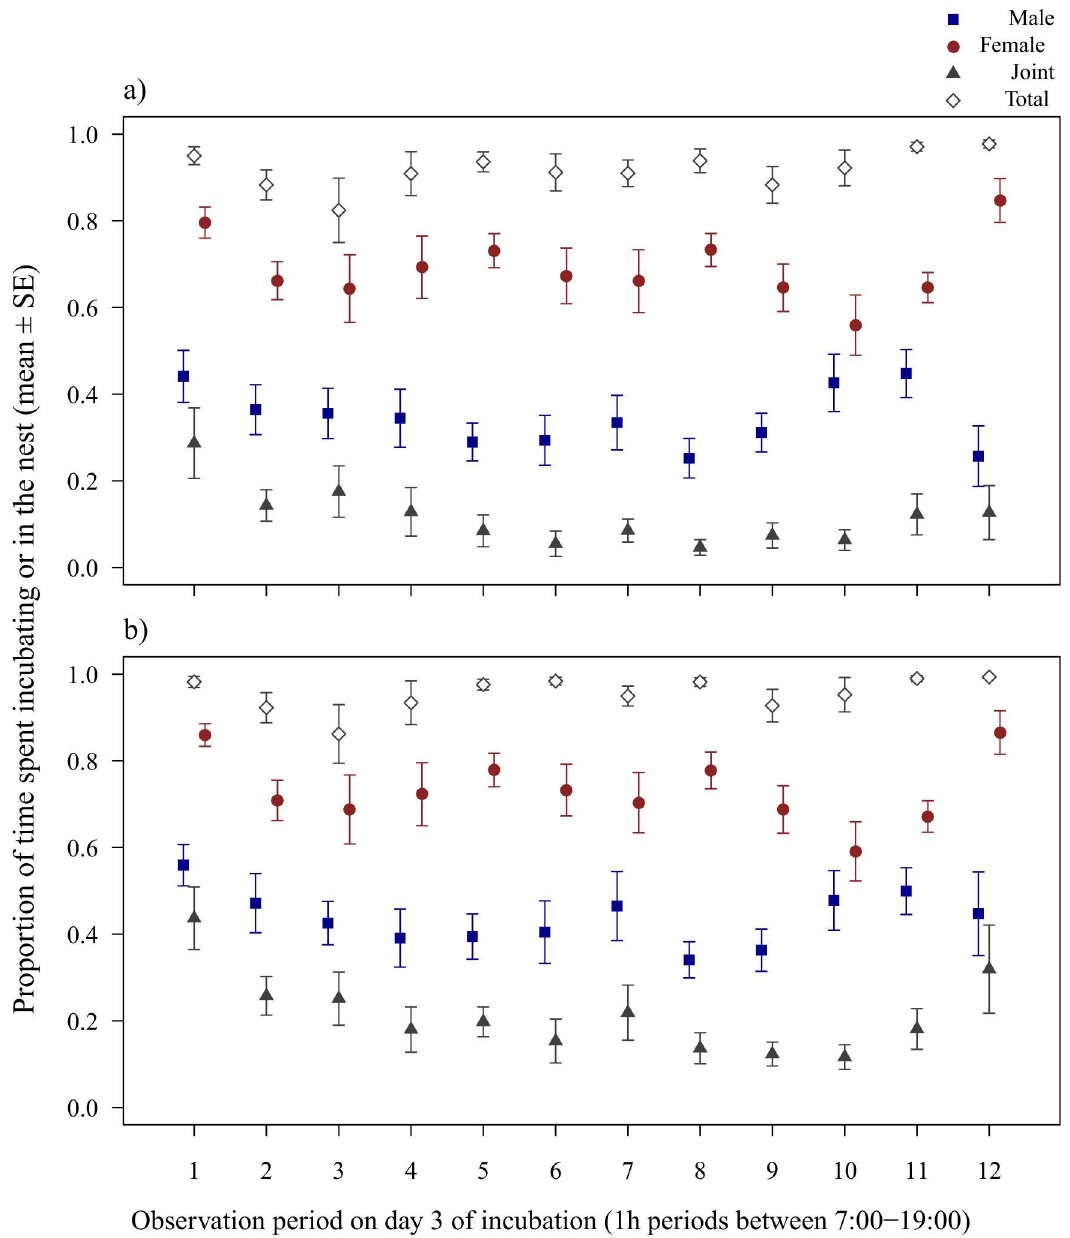
Fig 4. Diurnal variation of parental effort in zebra finches on day 3 of incubation. Mean ± SE proportionof 1h observationperiodsspent incubating (a) and in the nest (b) between7:00–19:00. Blue filled squares represent male, red filled circles female, grey filled trianglesjoint (male and female simultaneous) and grey open diamondstotal parentaleffort (when at least one parent incubatesor attends the